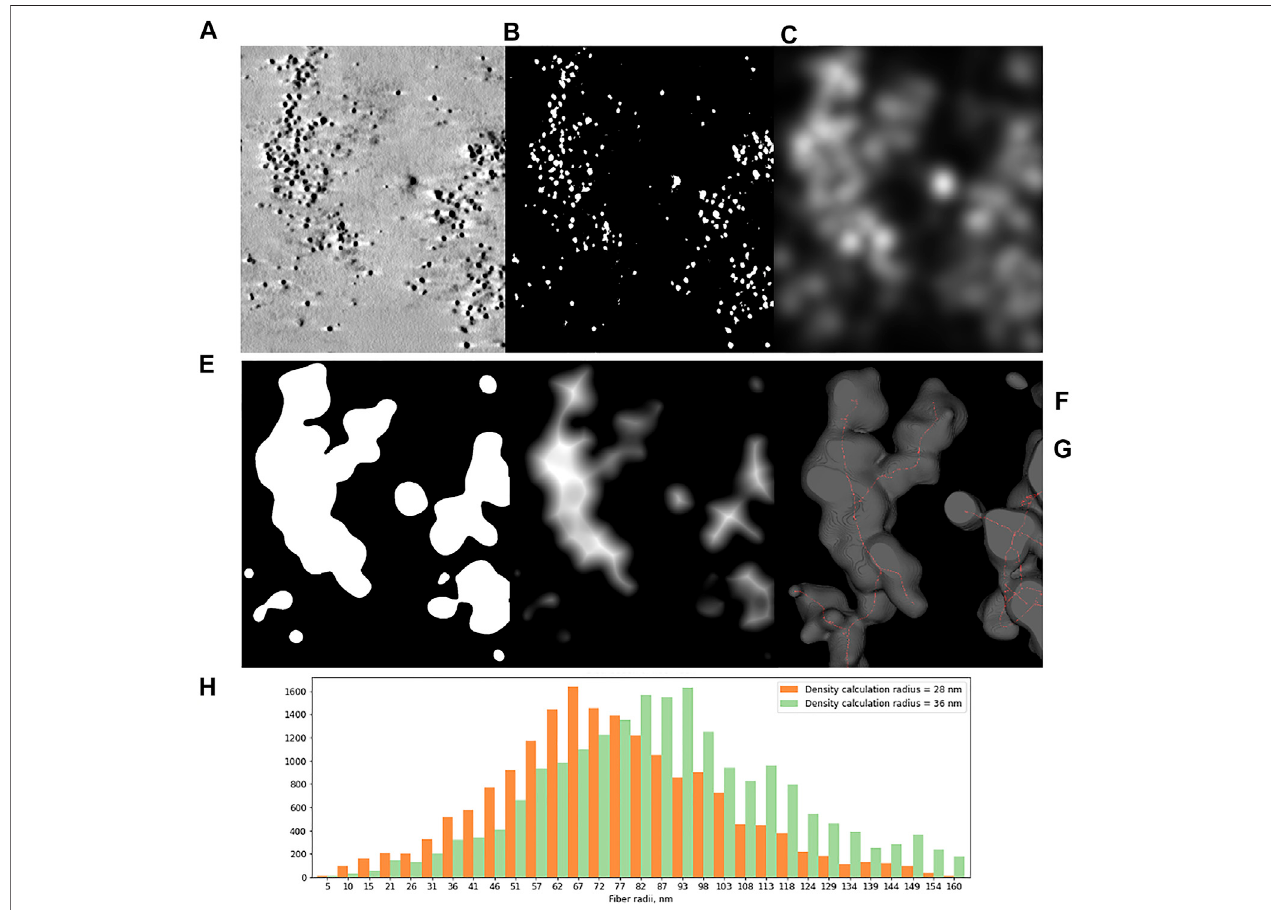
FIGURE4 | Tomographic slice of HT1080 cell nucleus labeledwith 2 h pulse of EdU and detectedwithbiotin-azide and streptavidin-Nanogold (A) and main steps of image analysis. (B – F) (B) Segmentation of Ag-enhanced Au particles. (C) 3D density calculation for different radii. The plot demonstrates total number of clusters depending on density calculation radius, green lines indicating the thresholds used for further calculations. (D) 3D density map. (E) Thresholded 3D density map. (F) 3D Distance map; Bar, 500 nm. (G) Histograms of local thickness distribution, calculated for two clustering thresholds show modal radii of higher-order chromatin fi bers between 75 and 90